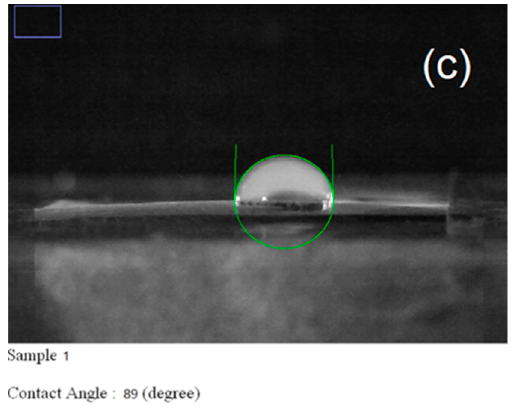
Figure 1. ( a ) Scanning electron microscope (SEM) images, ( b ) fiber diameter distribution, ( c ) the contact angle of PVP nanofibers.